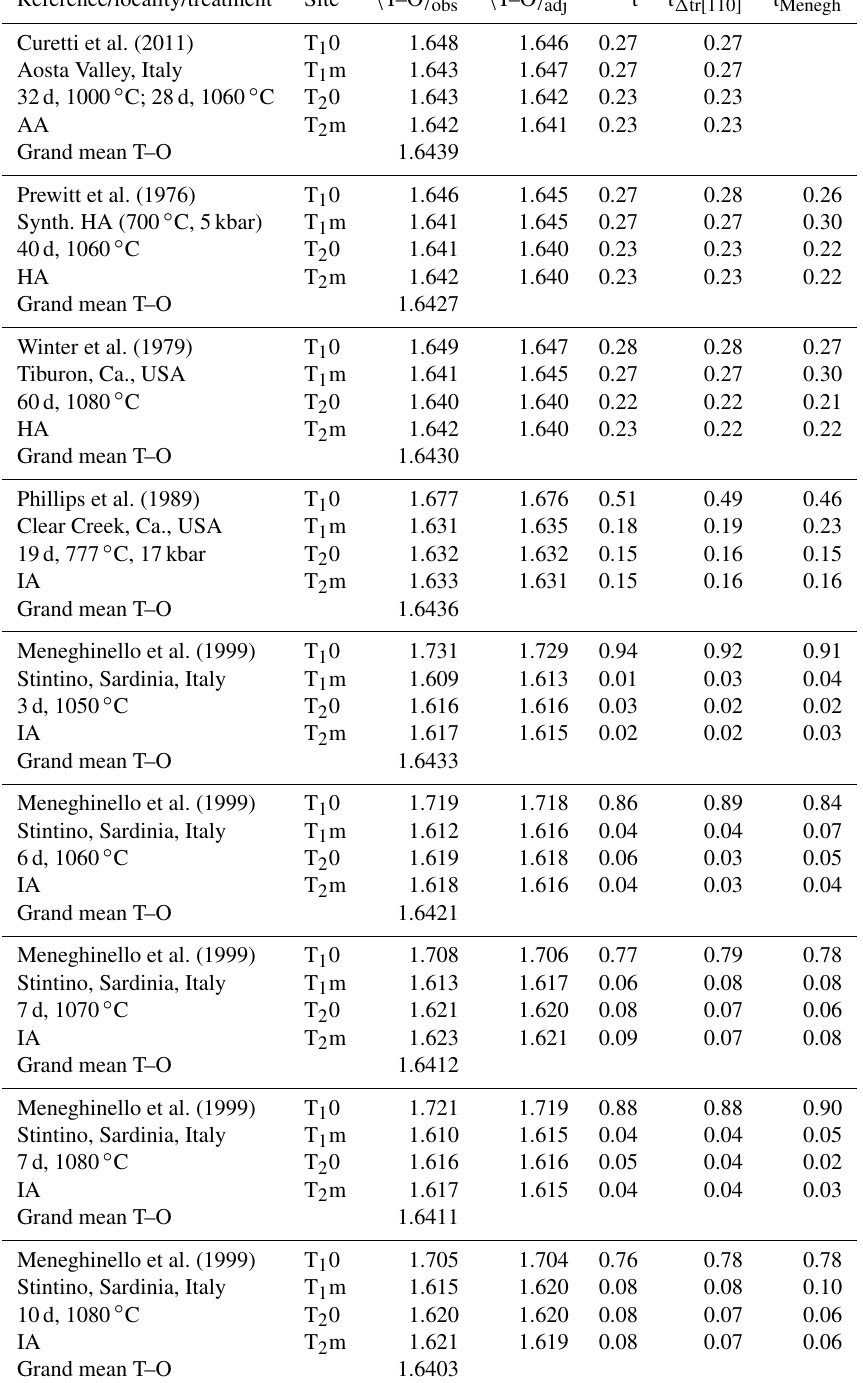
Table 3. Mean tetrahedral distances, (cid:104) T–O (cid:105)[ Å ] , and Al site occupancies, t, of 16 intermediate to high albites and 1 analbite. (cid:104) T–O (cid:105) adj and t were obtained from Eq. (9). Values of t (cid:49) tr [ 110 ] were derived from the length difference (cid:49) tr[110] (Eq. 13). t values have been normalised to (cid:54) t = 1. Site occupancies t Menegh from Meneghinello et al. (1999) are listed for comparison.